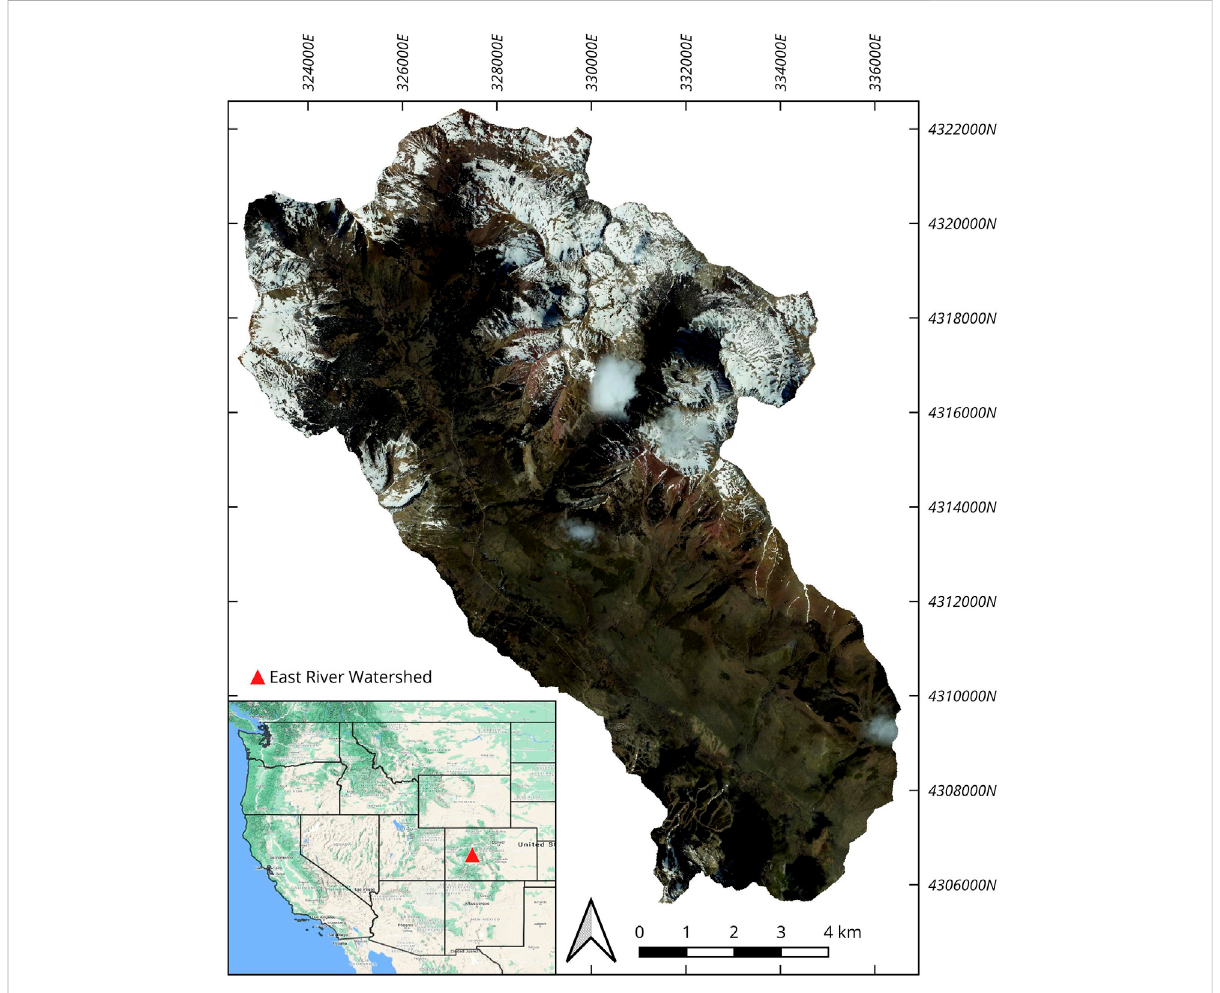
FIGURE 1 Areal overview of theEastRiver Watershed basin and itslocationshown relativeto theWesternUnitedStates.(Insertmap baselayer:Map data © 2021